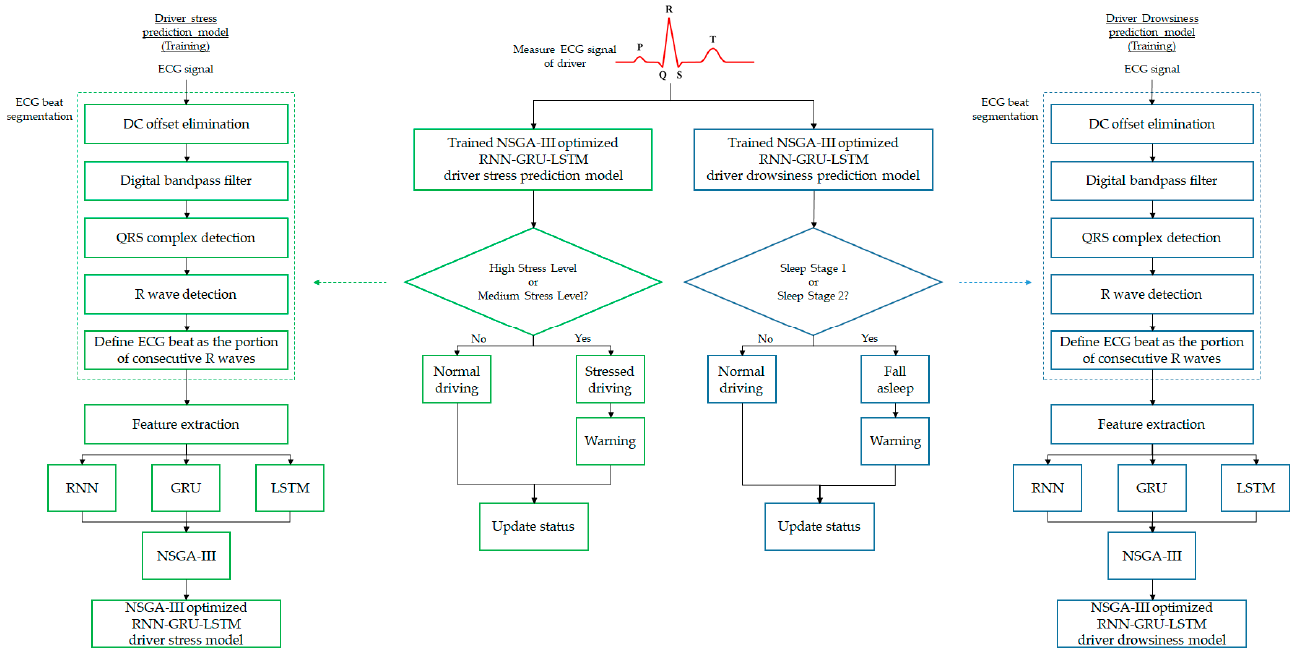
Figure 1. Conceptual diagram of the proposed nondominated sorting genetic algorithm-III (NSGA-III) optimized recurrent neural network (RNN), gated recurrent unit (GRU), and long short-term memory (LSTM) model.